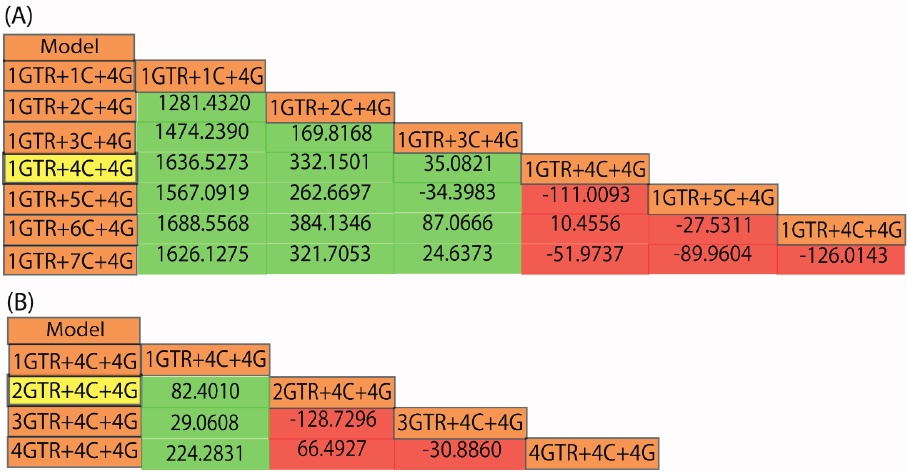
Figure 5. Bayes factor analysis for RomiguierTopAT with heterogeneous models. The results depicted in (A) and (B) are for RomiguierTopAT, in both cases the BF result indicating the model of best fit is depicted in yellow. The overall model of best fit (for composition vectors and rate matrices) is 2GTR + 4C + 4G. ( A ) The lower triangular matrix of Bayes Factors used to find the optimum number of composition vectors for the model; ( B ) The lower triangular matrix of bayes factors used to find the optimum number of rate